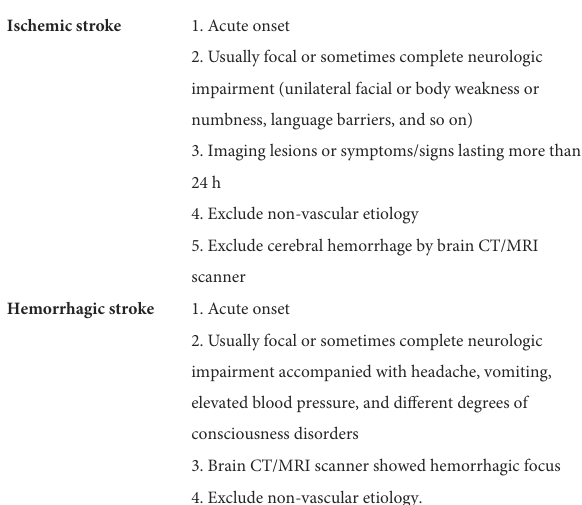
TABLE 1 Diagnostic criteria of